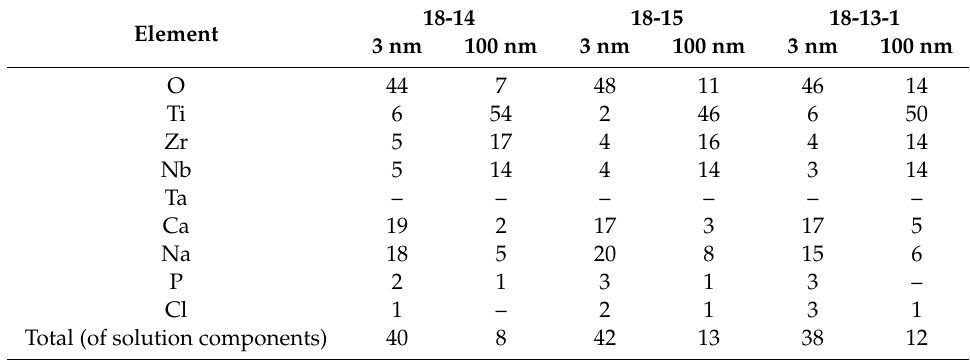
Table 4. Surface elemental compositions of the 18-14, 18-15, and 18-13-1 alloys at different analysis depths (atom %); after exposure to Hanks’ solution.